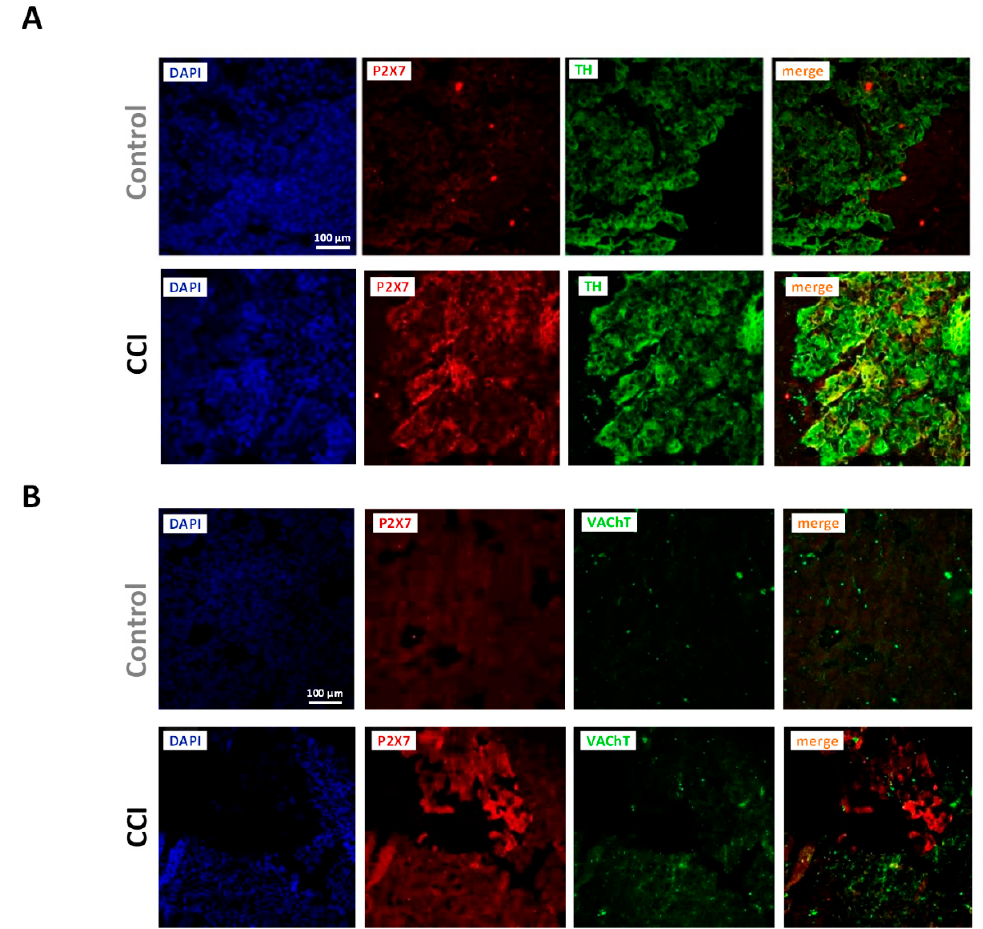
Figure 8. Increased P2X7 receptor immunoreactivity in chromaffin cells from CCI animals. ( A ) Fluorescence confocal images of adrenal gland slices from Control (upper panels) and CCI animals (lower panels) stained for P2X7 receptor and tyrosine hydroxylase (TH). ( B ) Fluorescence confocal images of adrenal gland slices from Control (upper panels) and CCI animals (lower panels) stained for P2X7 receptor and the vesicular acetylcholine transporter (VAChT). Cell nuclei in ( A , B ) were visualized following incubation with DAPI. Images are representative of those obtained from 3 Control and 3 CCI animals.